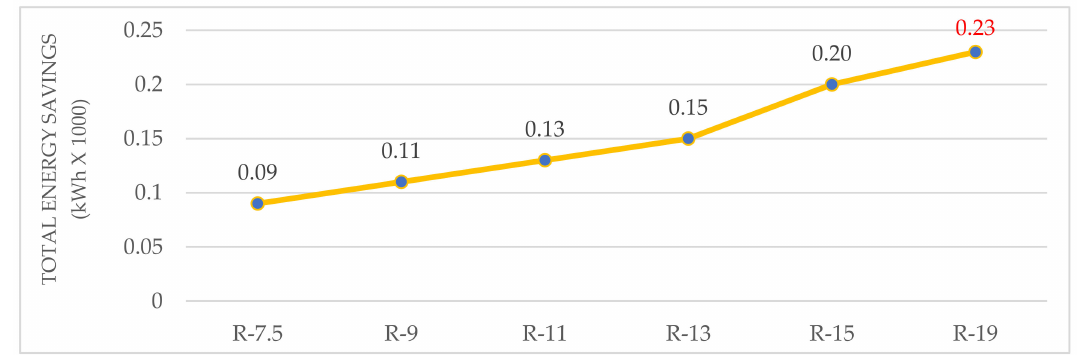
Figure 11. The impact of using additional wall insulation on total annual electricity consumption of a